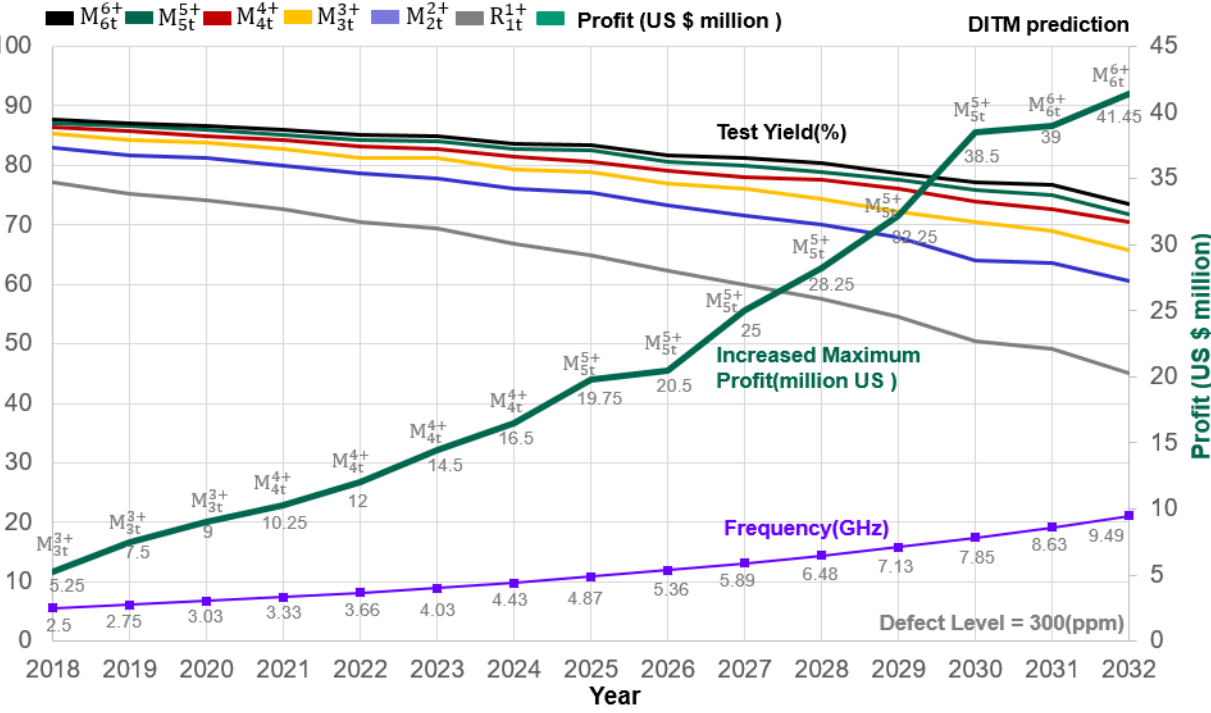
Figure 14. Influence of the number of multiplex testing times on the testing cost and profitability.